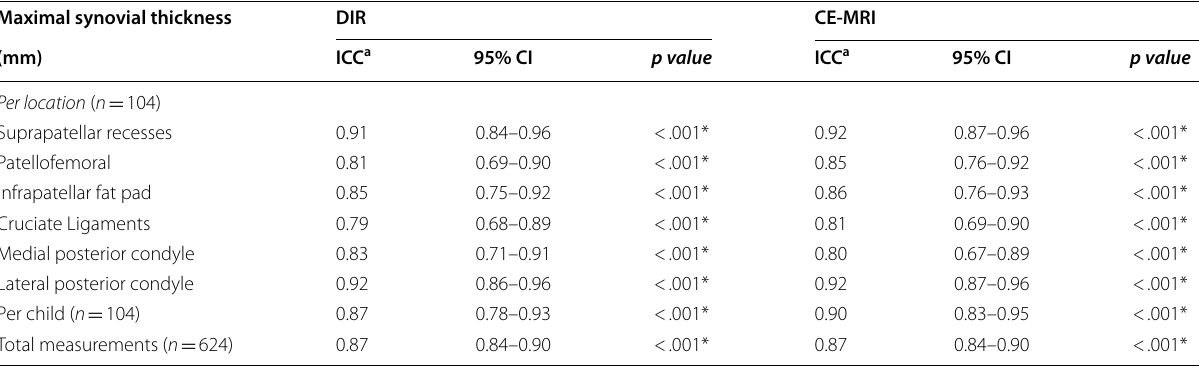
Data are based on the aggregated measurements of 4 readers DIR, double inversion recovery; CE, contrast-enhanced; ICC, intraclass correlation coefficient; CI, confidence interval * p value < .05 a Based on single-measurement, absolute-agreement, two-way random effects model